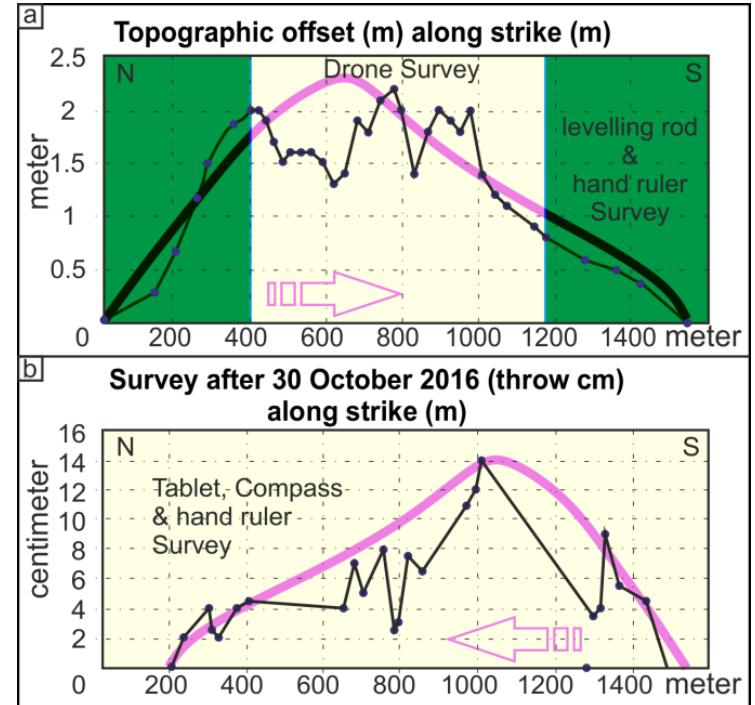
Figure 11. Comparison between the topographic fault scarp (( a ), in meters) and the coseismic slip profile (( b ), centimeters) surveyed following the 30 October 2016 earthquake (Mw 6.5) along the PTP.